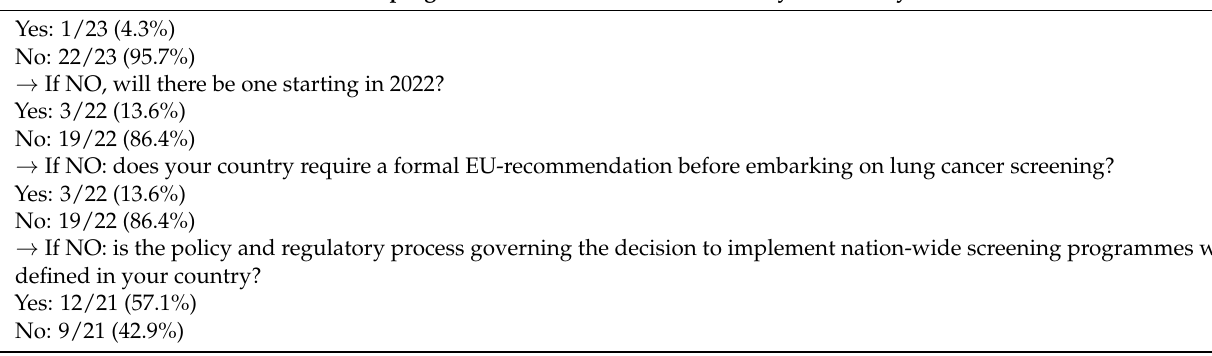
Table 1. Survey of key opinion leaders from European countries: questions and